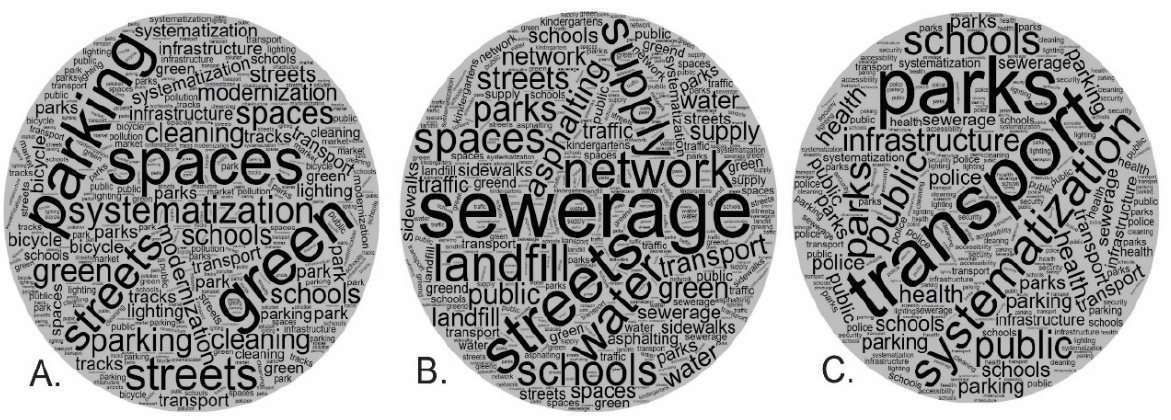
Figure 9. ( A ) Noul Titan, ( B ) Militari–Chiajna, and ( C ) Cosmopolis: residents’ recommendations to local authorities for improving housing standards, based on survey-derived information.